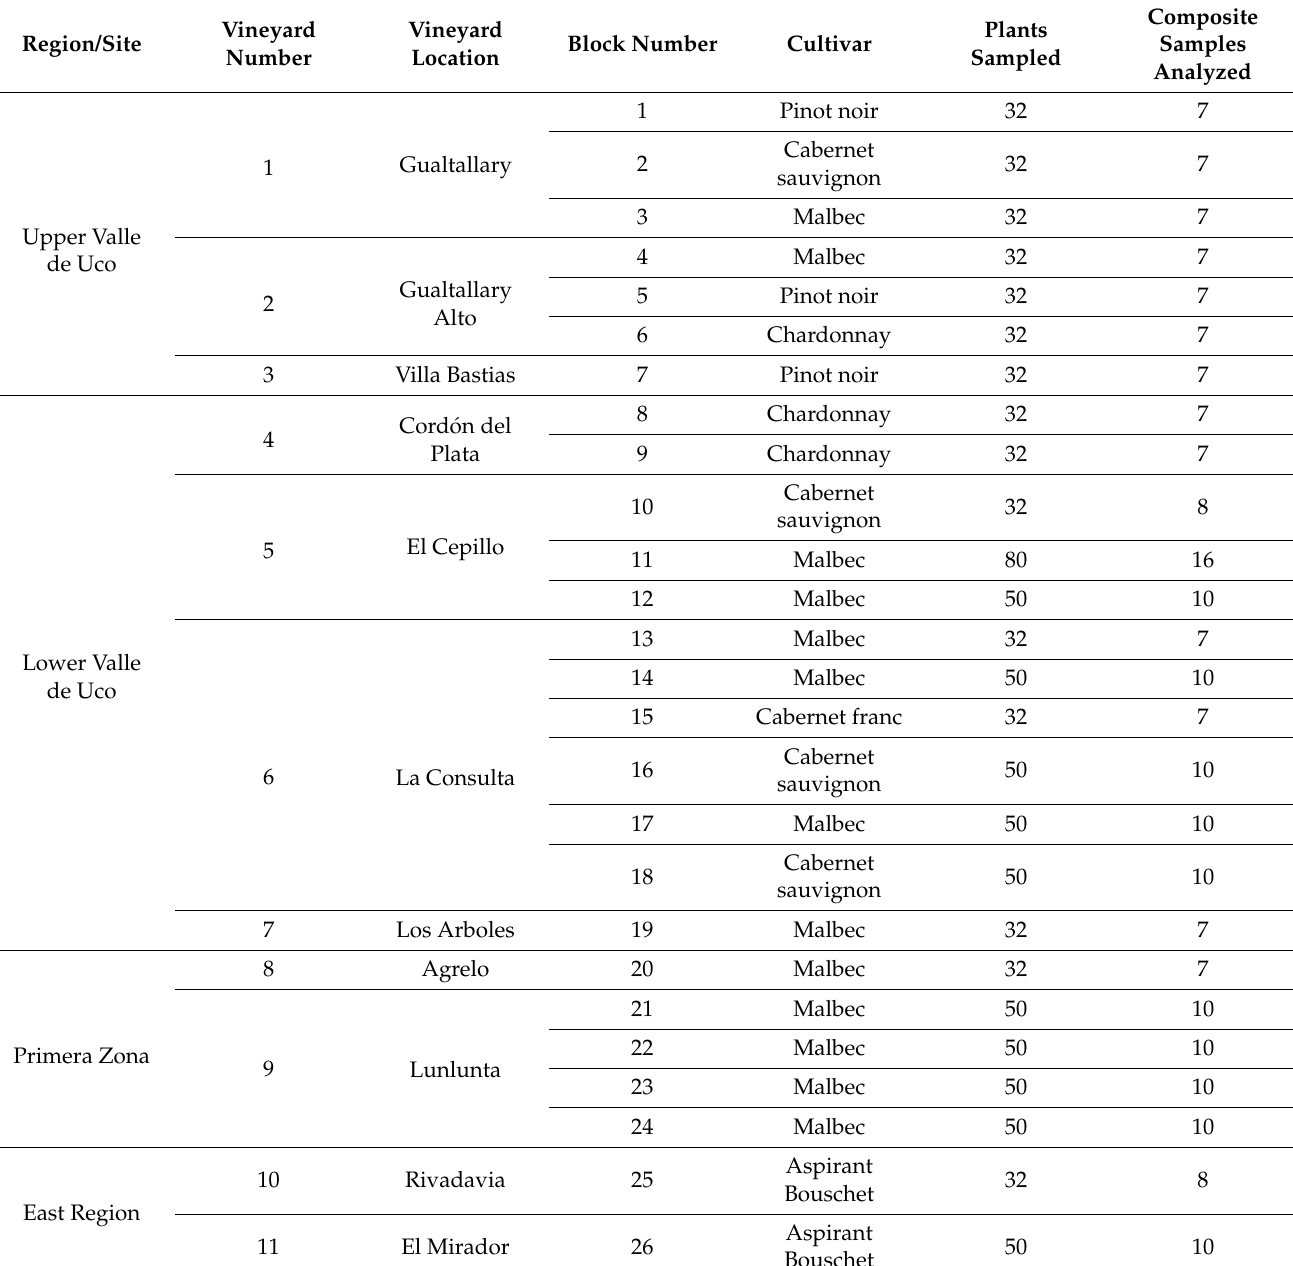
Table 1. Grapevine sampling in the four regions